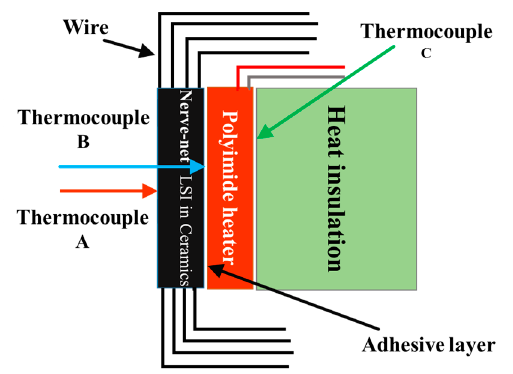
Figure 9. TCR measurement of Cu film heater.